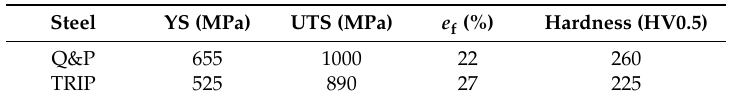
Table 2. Main mechanical properties of the Q&P and TRIP steels. UTS: ultimate tensile strength; YS: yield strength; e f : elongation at